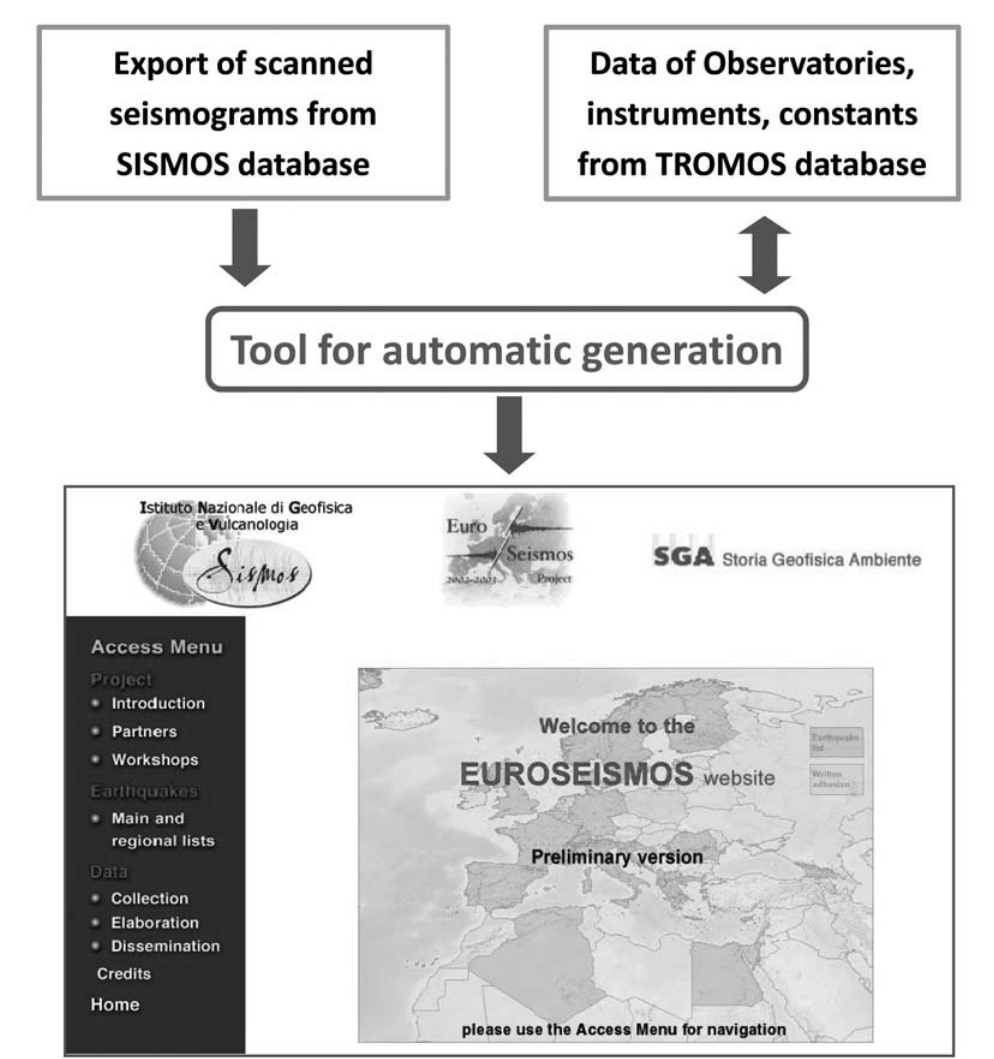
Fig. 18. Simplified scheme of the procedure for updating the EUROSEISMOS